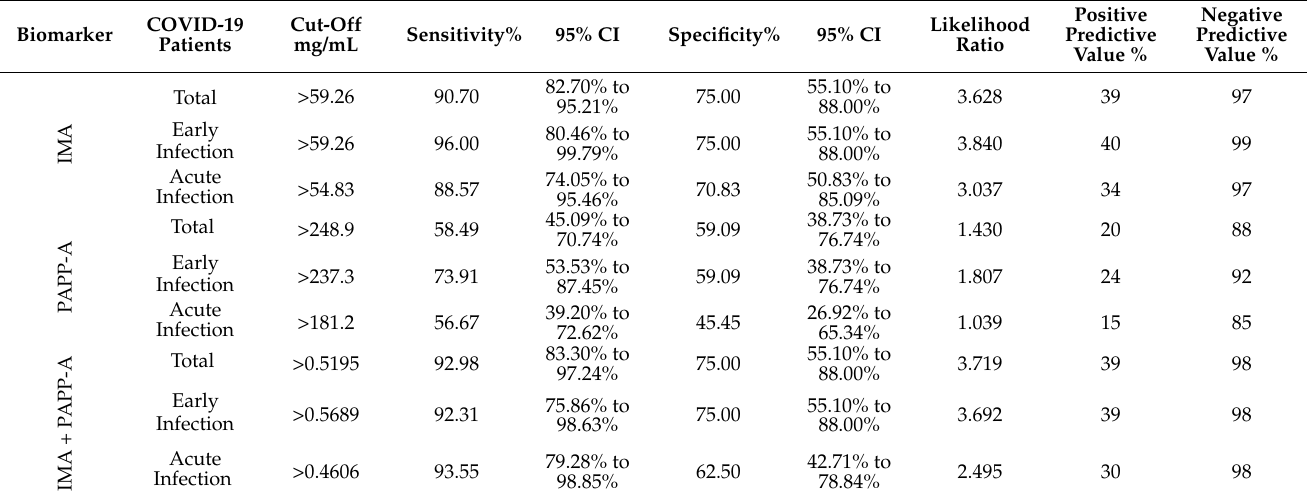
Table 2. Sensitivity, specificity, likelihood ratio, positive predictive value and negative predictive value for ischemia- modified albumin (IMA), pregnancy-associated plasma protein-A (PAPP-A) and the combination of both biomarkers in COVID-19 patients.